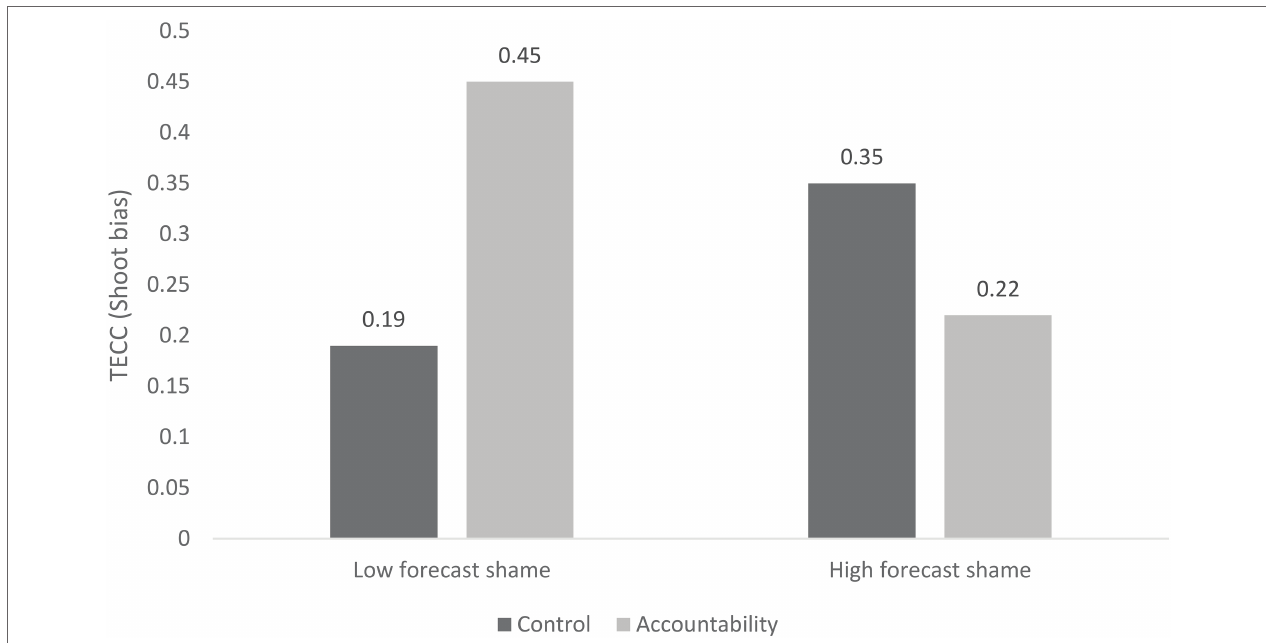
FIGURE 2 | Interaction between forecast group-based shame and accountability predict tolerance of enemy collateral casualties as decision-making bias in Study